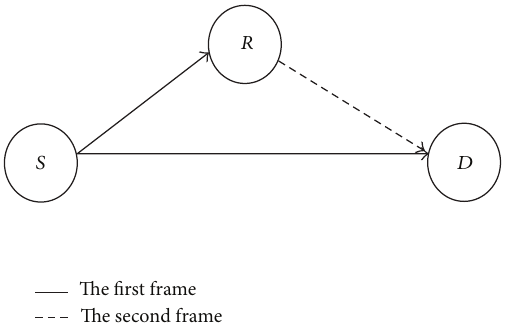
Figure 1: Coded cooperative communication